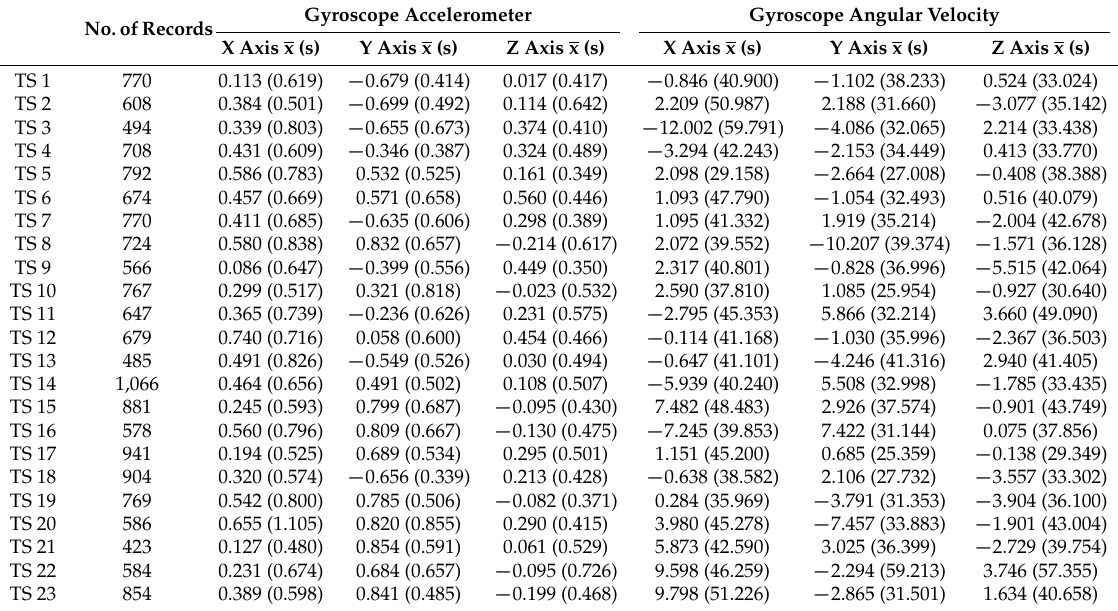
Table A4. Anomaly conditions dataset. Part